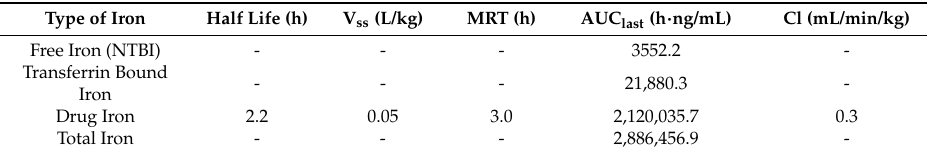
Table 4. Pharmacokinetic parameters.